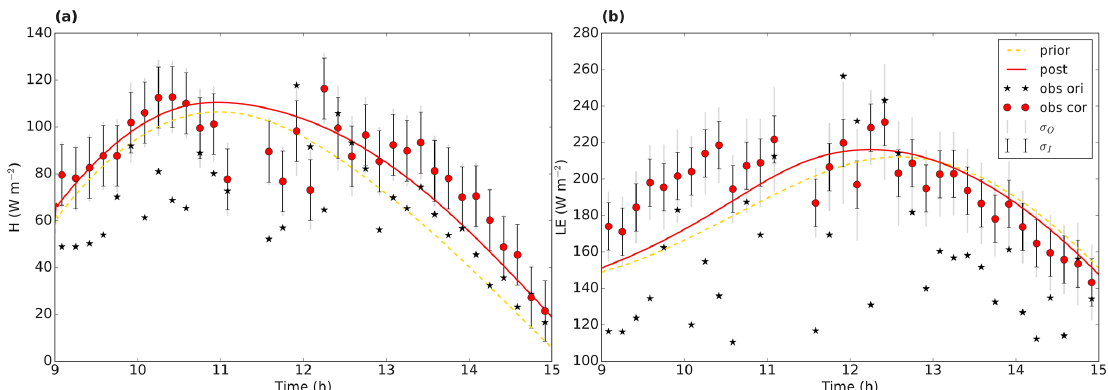
Figure 6. Energy balance data, with (a) sensible heat flux and (b) latent heat flux, for the Cabauw case. The black stars are the original observations, and the red dots the observations after forced closure of the energy balance. The error bars indicate the measurement error standard deviation σ I and the total observational error standard deviation σ O . The full red line shows the optimised model (“post” means posterior), and the dashed yellow line is the prior model.